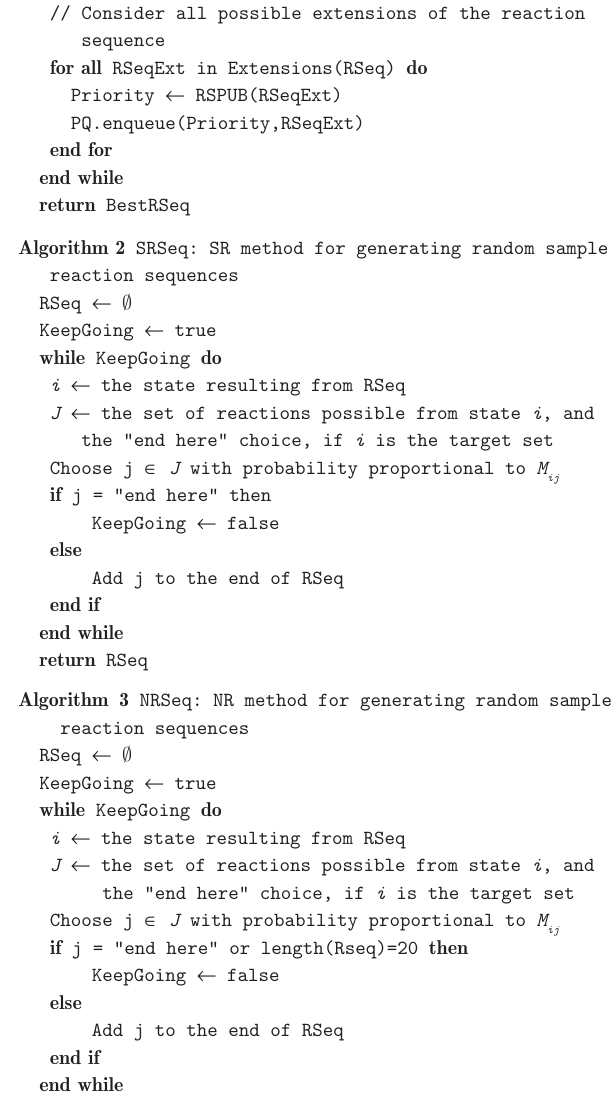
Algorithm 1 Best-first search for optimal reaction